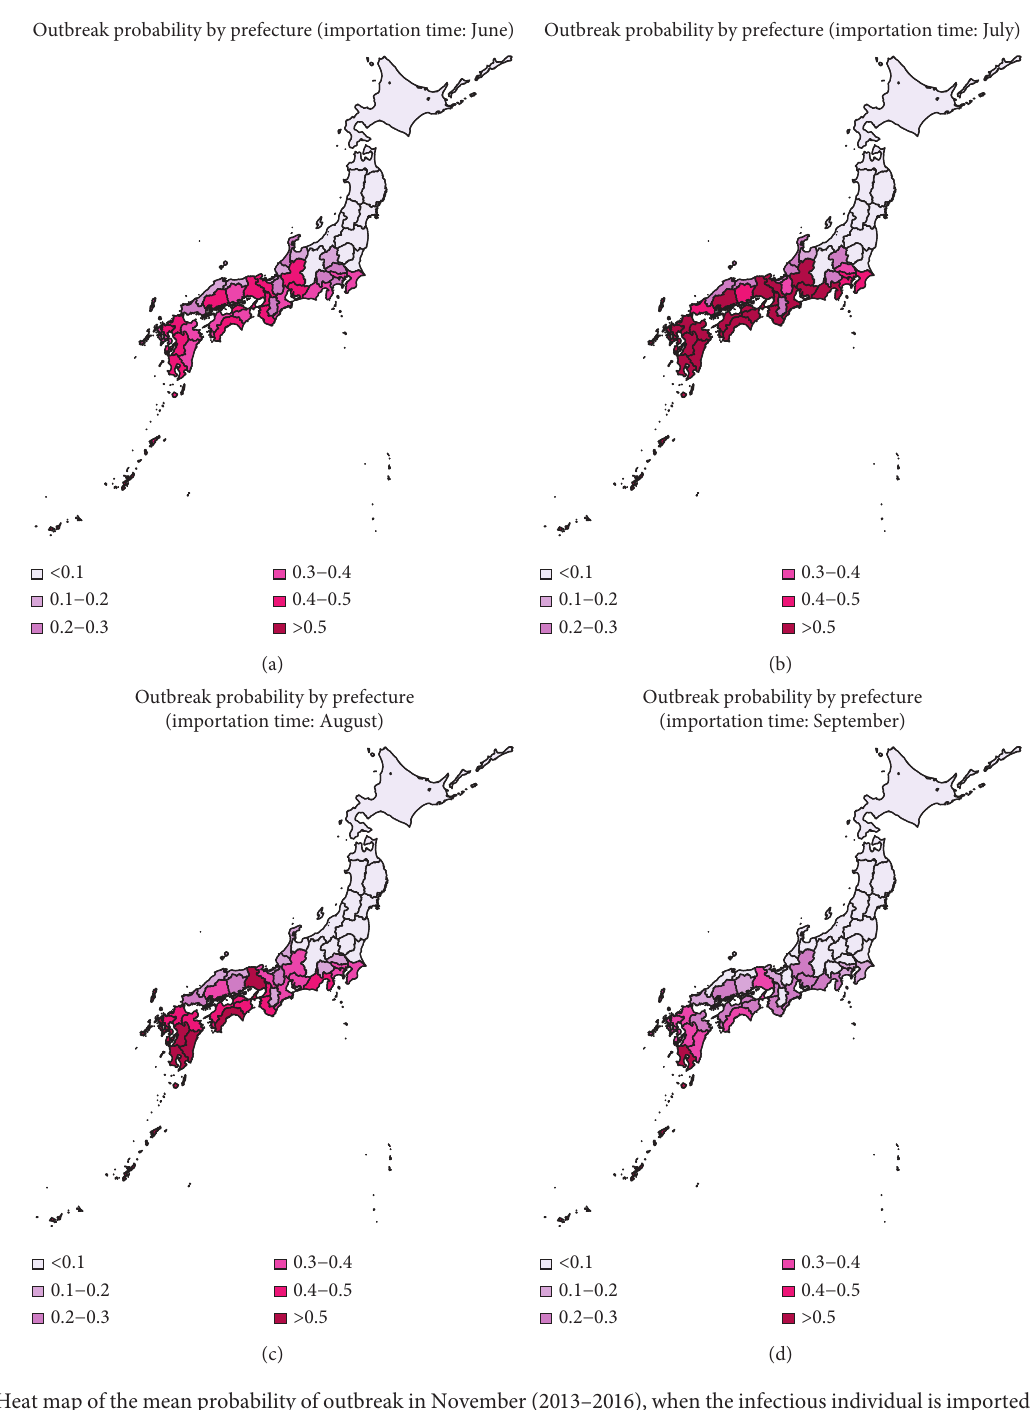
Figure 6: Heat map of the mean probability of outbreak in November (2013–2016), when the infectious individual is imported in June, July, August, and September; k �